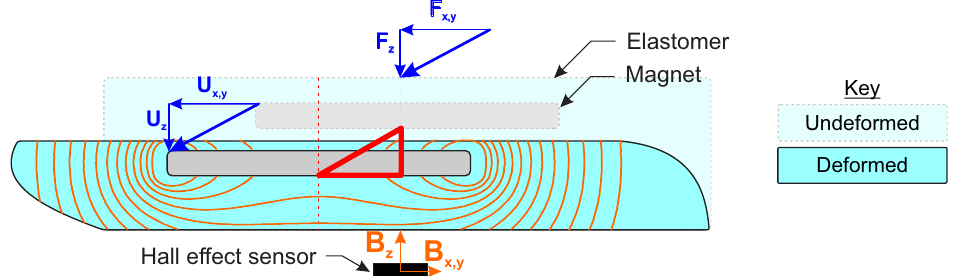
Figure 2. Schematic of the soft Hall effect tactile sensor, indicating the associated measurement parameters: F x , y , z —Applied force; U x , y , z —Sensor Surface Displacement; B x , y , z —Measured magnetic field at the Hall effect sensor (black rectangle); The triangular workspace of the sensor is indicated in